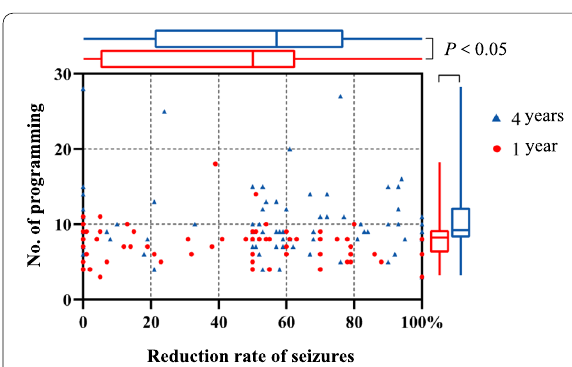
Fig. 2 Remote modulation improved the efficacy of